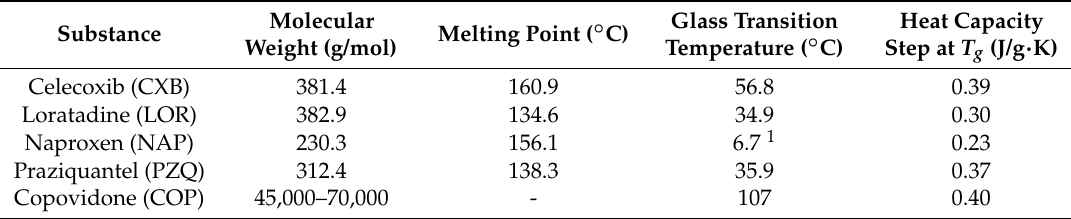
Table 1. Physicochemical properties of the substances used. The molecular weight was taken from the PubChem Substance and Compound databases [26], all of the other parameters were experimentally